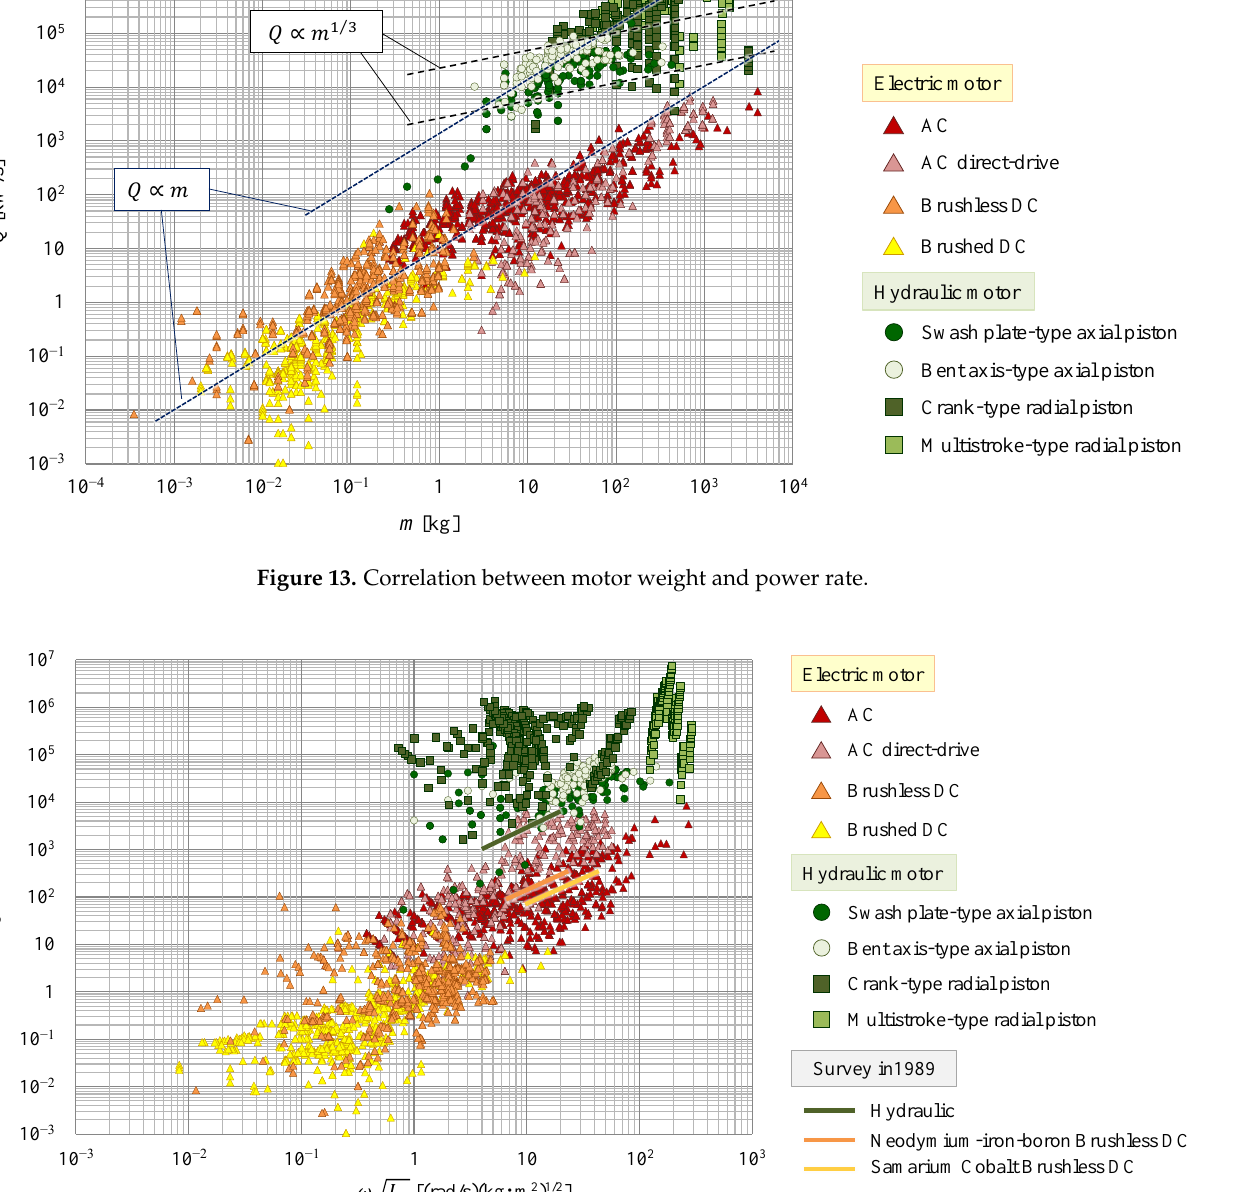
Figure 15. Correlation between rated output power and power rate density.